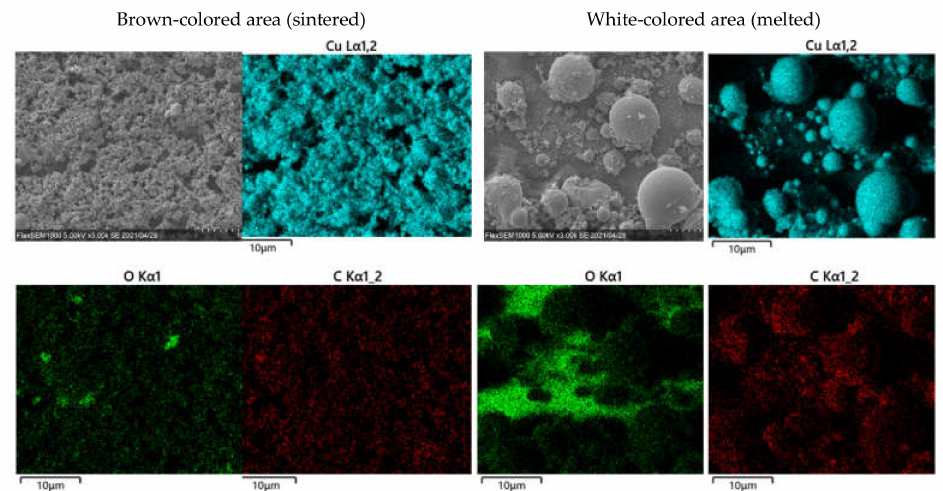
Figure 6. SEM images and EDS mappings of patterns fabricated under Ar gas injection rates of 125